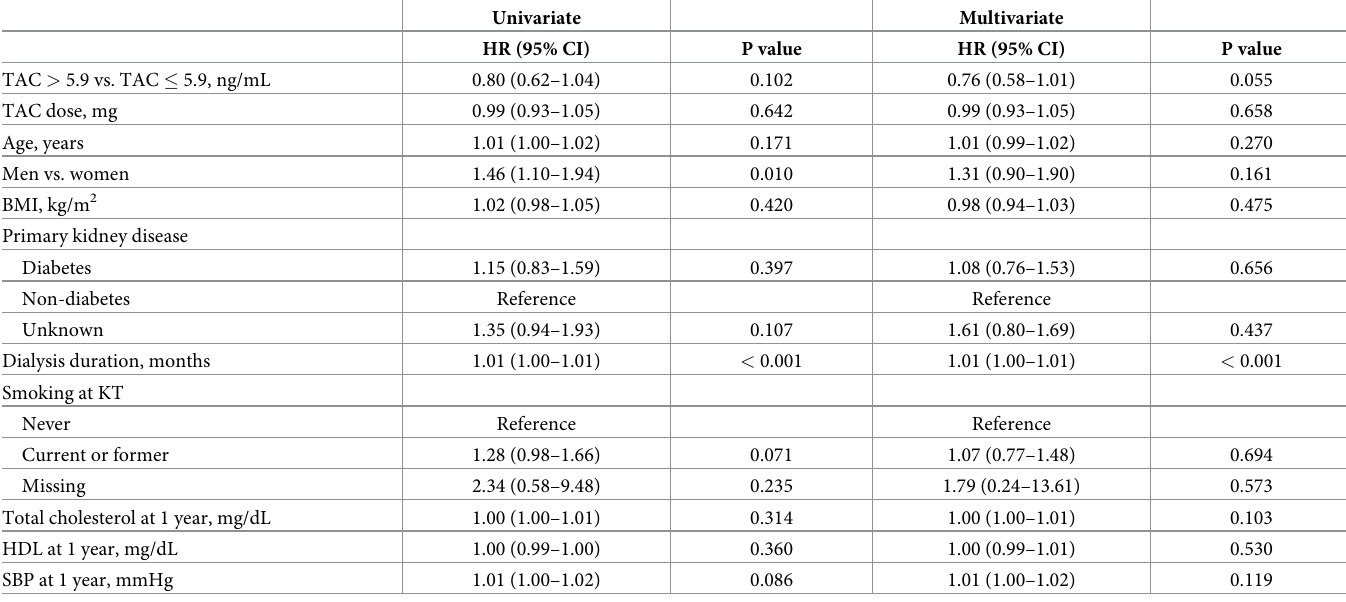
Table 4. Univariate and multivariate Cox regression analysis for cardiovascular composite